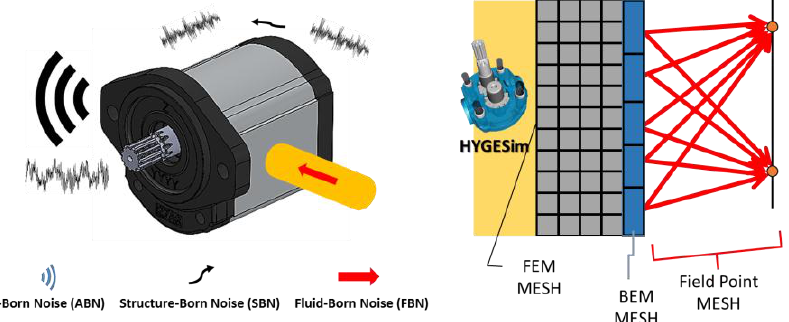
Figure 3. Transmission of sound from working fluid to field points.